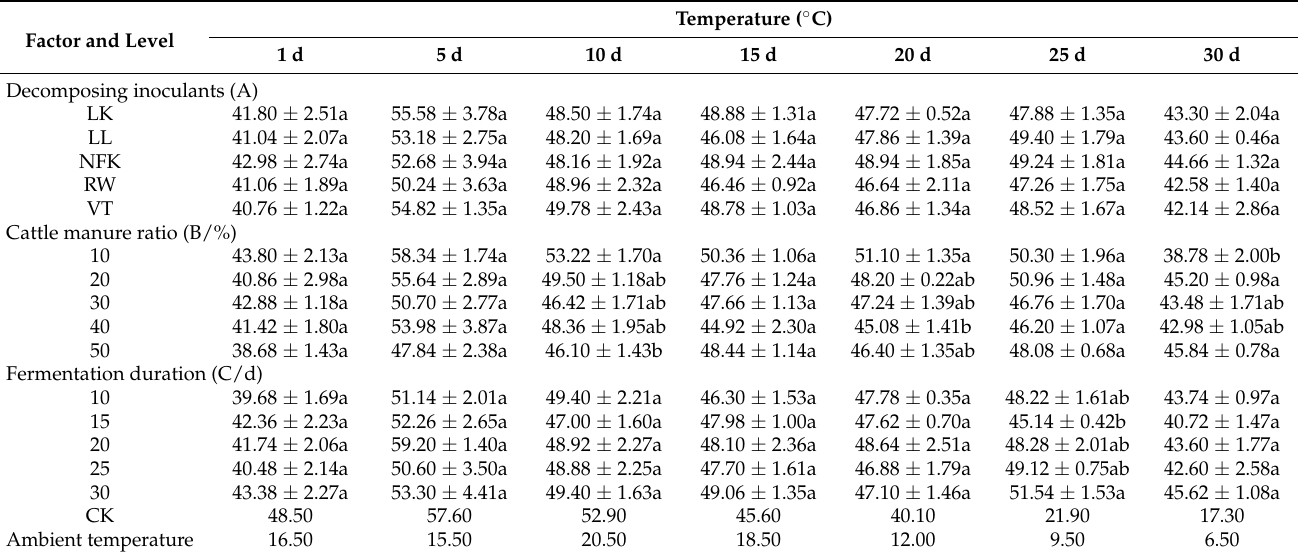
Table 4. Effect of the decomposition inoculant, cattle manure ratio, and fermentation duration on the fermentation temperature of the material